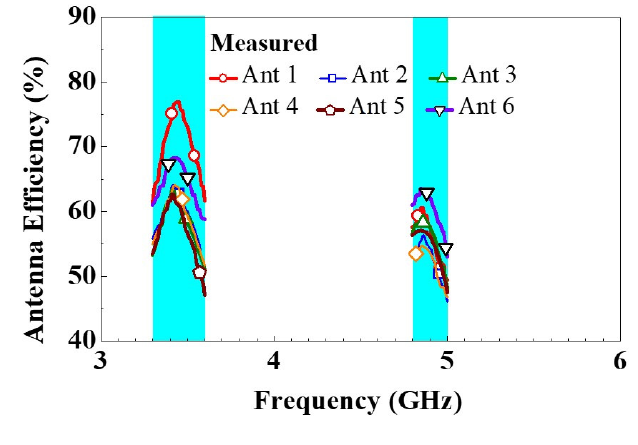
Figure 7. ECCs calculated from the complex E-field radiation patterns ( a ) simulated and ( b ) measured for the 5G antenna system.